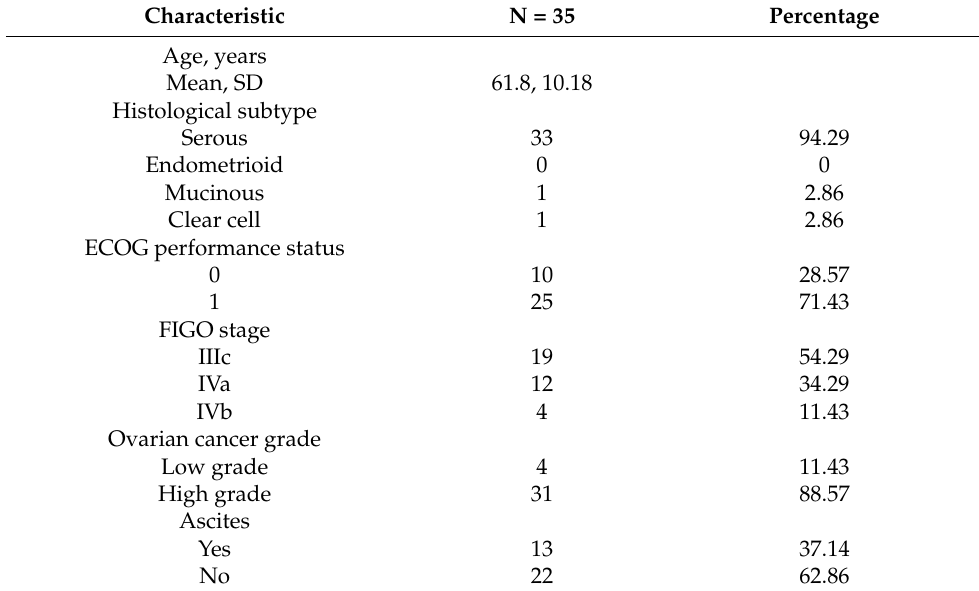
Table 1. Baseline clinical